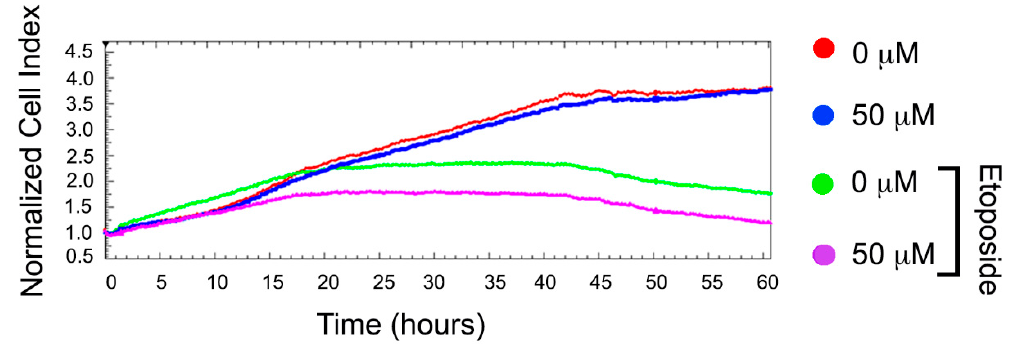
Figure 3. BT44 sensitizes colon HCT-116 cancer cells to etoposide. HCT-116 cells were seeded to wells of E-plates and after being attached to the bottom were incubated with BT44 in concentrations 50 µM; 2 h later 100 µM of etoposide was added. Recording with the aid of xCELLigence equipment was